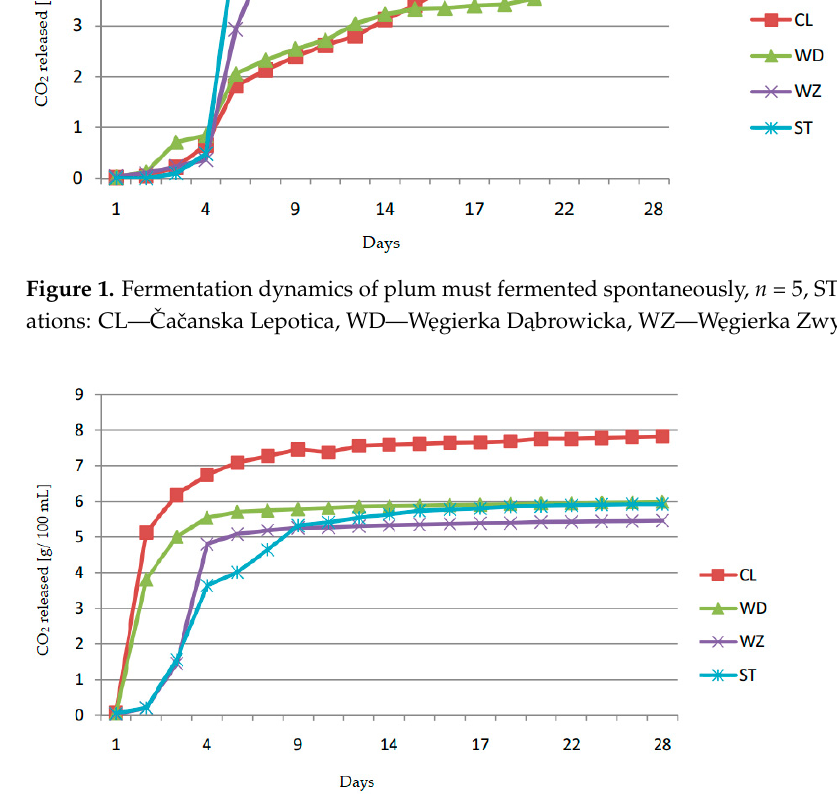
Figure 3. Fermentation dynamics of plum must fermented with H. uvarum H2, n = 5, STD < 5%. Abbreviations: CL— Č a č anska Lepotica, WD—W ę gierka D ą browicka, WZ—W ę gierka Zwyk ł a, ST—Stanley.